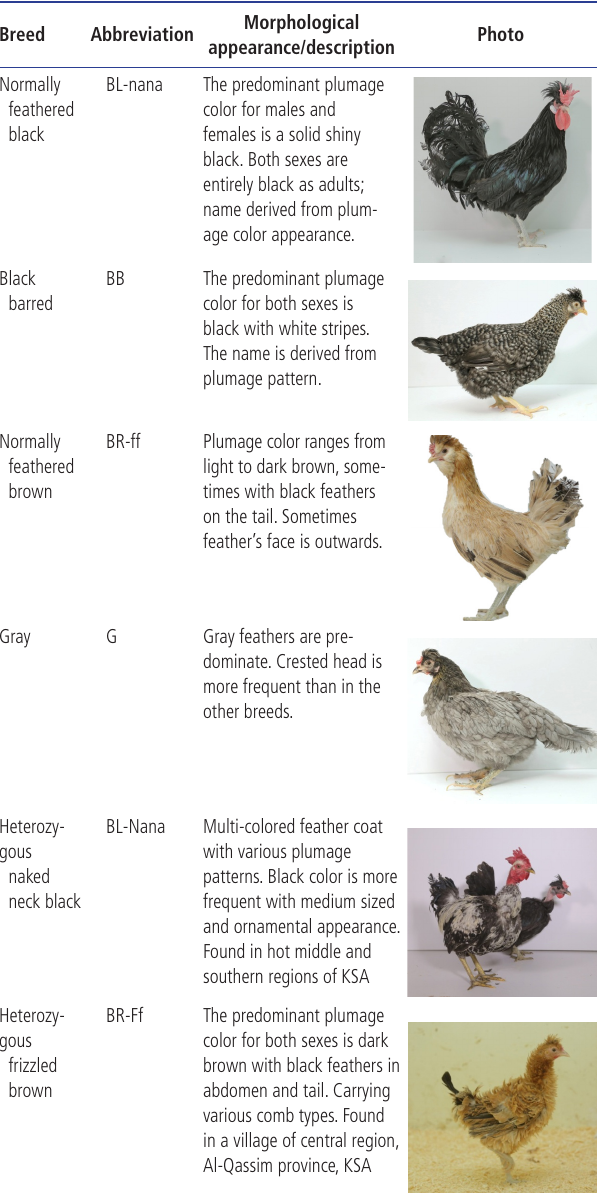
Table 1. Description of morphological appearance of the Saudi native